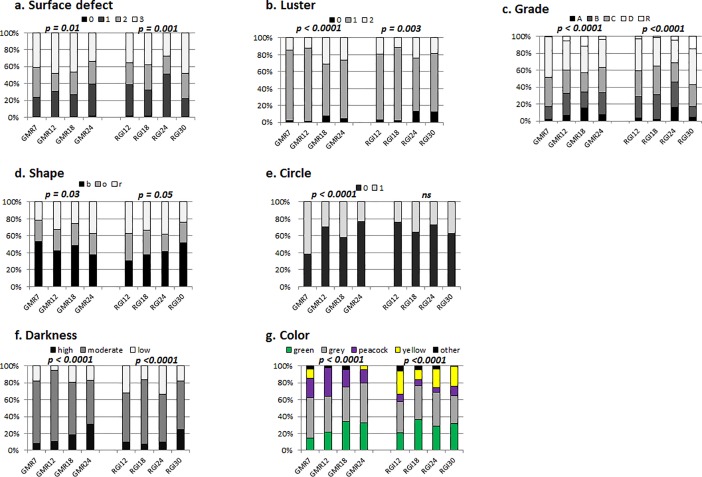
Cultured pearl quality traits from the experimental graft distribution.Percentage of cultured pearls for each experiment in Gambier (GMR) and Rangiroa (RGI) for different donors in different age groups (7, 12, 18, 24 and 30 months old) and the p-value in Gambier and Rangiroa with the following variables: a. surface defect classes (“0” = 0 defects, “1” = 1–5 defects, “2” = 6–10, and “3” = >10 defects), b. luster levels (“0” = absence of luster, “1” = moderate luster, and “2” = high luster), c. classification grade (“A” to “D” and Rejects), d. shape categories (“b” for baroque and semi baroque, “o” for oval and drop,” r” for round and semi round pearls), e. pearl circles (“0” = absence and “1” = presence), f. darkness level (low, moderate and high darkness) and g. visual color categories (“green”, “grey”, “peacock”, “yellow” and “other”, corresponding to white, blue and aubergine pearls). Datas available on S2 Appendix.